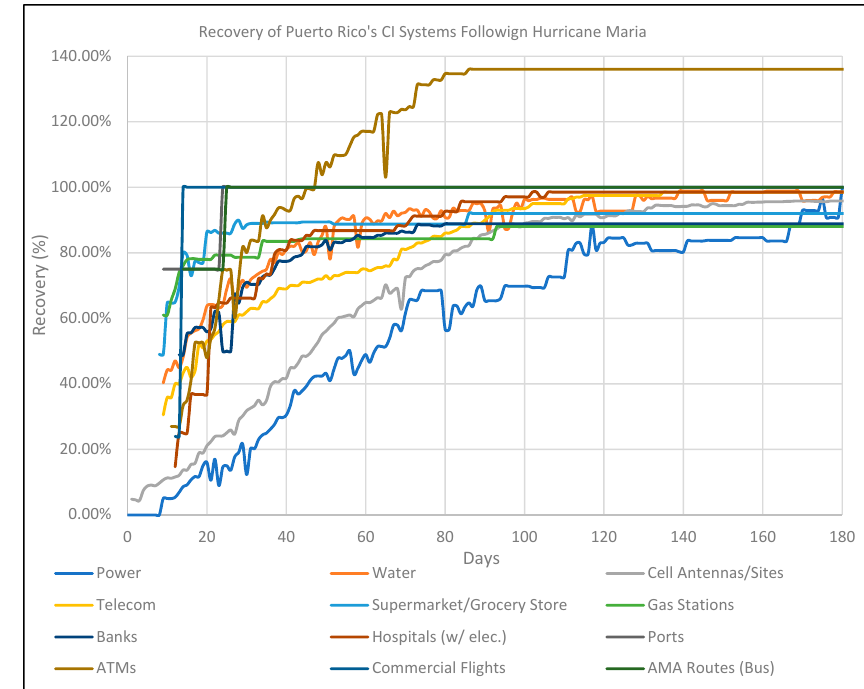
Figure 4. Daily recovery progress of CIS of Puerto Rico for the first six months after Hurricane Maria.